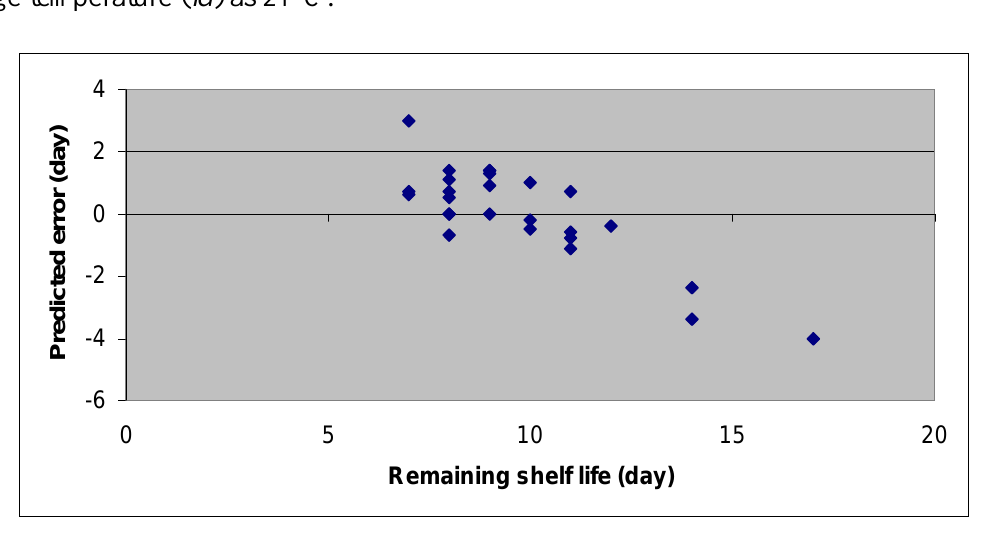
Figure 4. A 2-stage experimental model was validated with a commercial harvest of 26 cases of living lettuce. The predicted errors were calculated by specifying the future average temperature ( fa ) as 21 °